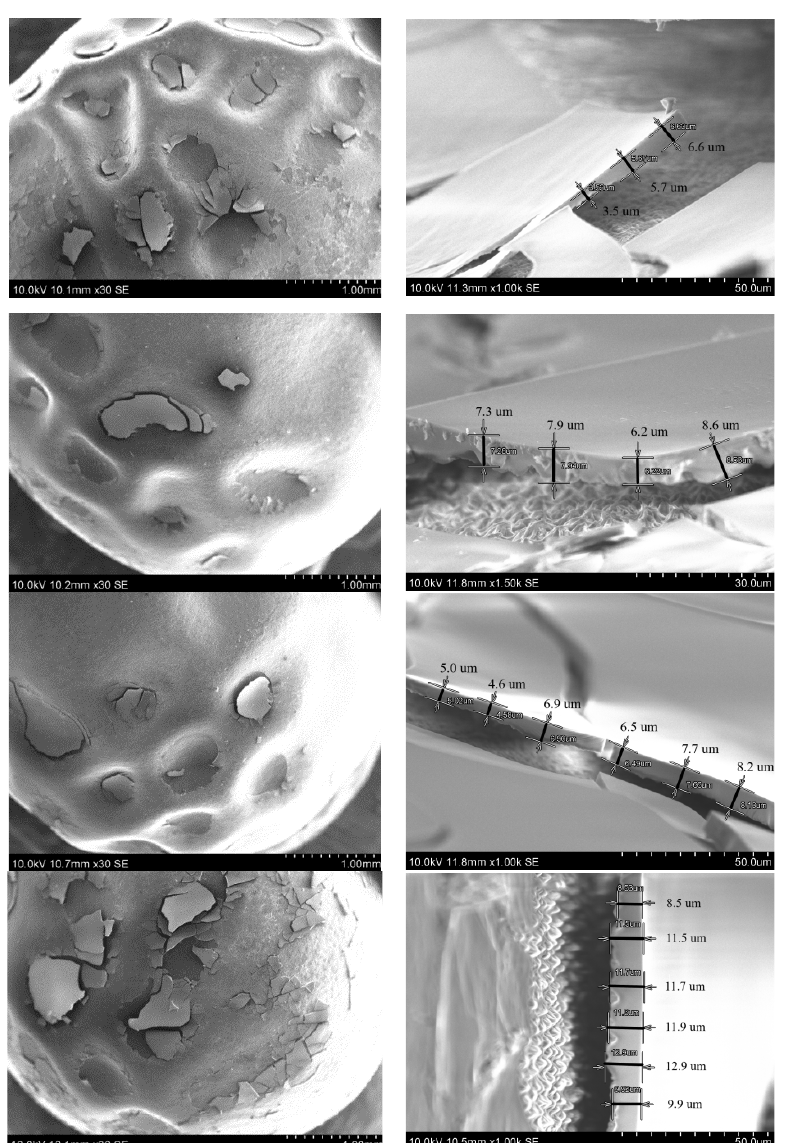
Figure 2. SEM micrographs of the pea seeds after different time of SiO 2 sol deposition: 5 min—ultrasonic bath ( first raw ); 10 min—ultrasonic bath ( second raw ); 30 min—ultrasonic bath ( third raw ); and 5 min in a container on a magnetic stirrer ( fourth raw ).